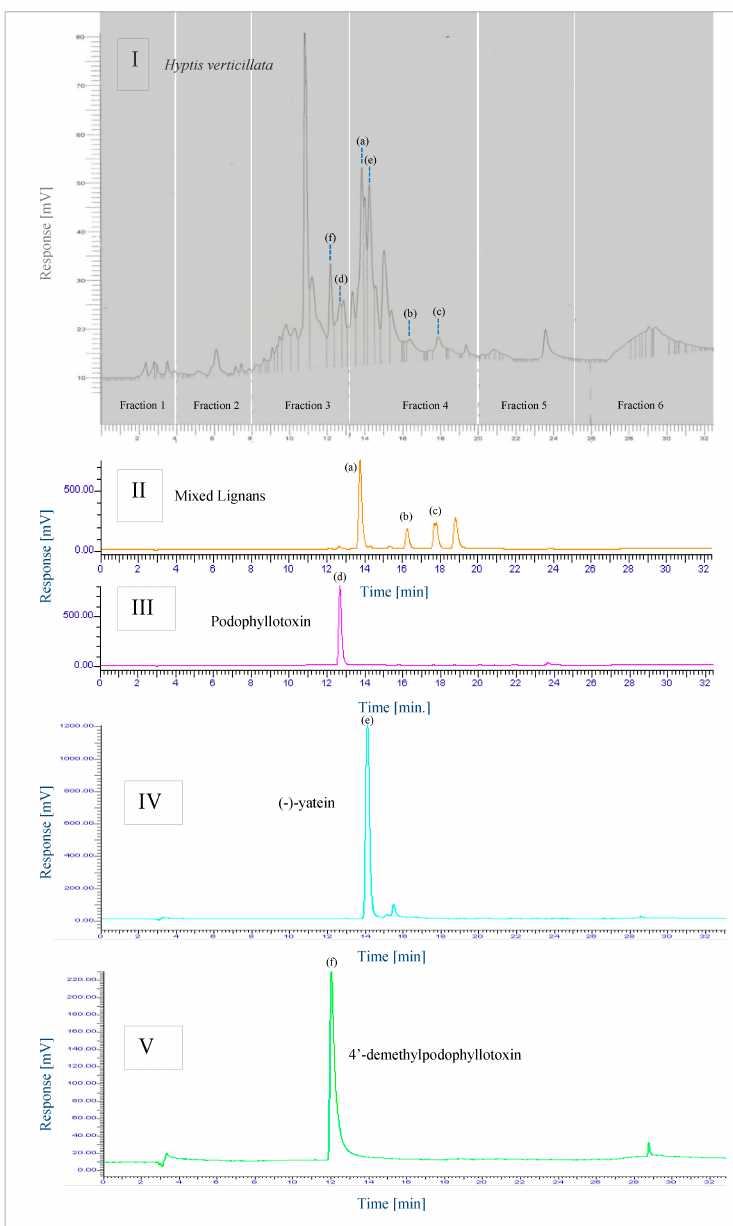
Figure A1. RP-HPLC analysis of reconstituted aqueous extract of H. verticillata ( I ) with comparison to standards: 5 lignan mix ( II ) [6 mg/mL]; podophyllotoxin ( III ) [7.8 mM]; (-)-yatein [10 mM] ( IV ) and 4 (cid:48) -demethylpodophyllotoxin [2 mM] ( V ). Separations were achieved using a Perkin-Elmer Series 200 chromatograph, Waltham, MA, USA fitted with a Chromsep C18, 250 × 4.6 mm, 5 µ m column and C18 guard column. An injection volume of 20 uL was independently run for H. verticillata ( I ) and each of the standards ( II , III , IV and V ) for 34 min at a flow rate of 1 mL/min. at wavelength 290 nm at an ambient temperature of 18 ◦ C. The mobile phase consisted of methanol and water using gradient elution: 20% methanol for 2 min increased to 60% linearly over 4 min and held for 2 min. Methanol was further increased to 80% linearly over 9 min and held for 7 min. The column was washed by running 100% methanol for 8 min then decreased to 20% to equilibrate the column for the next